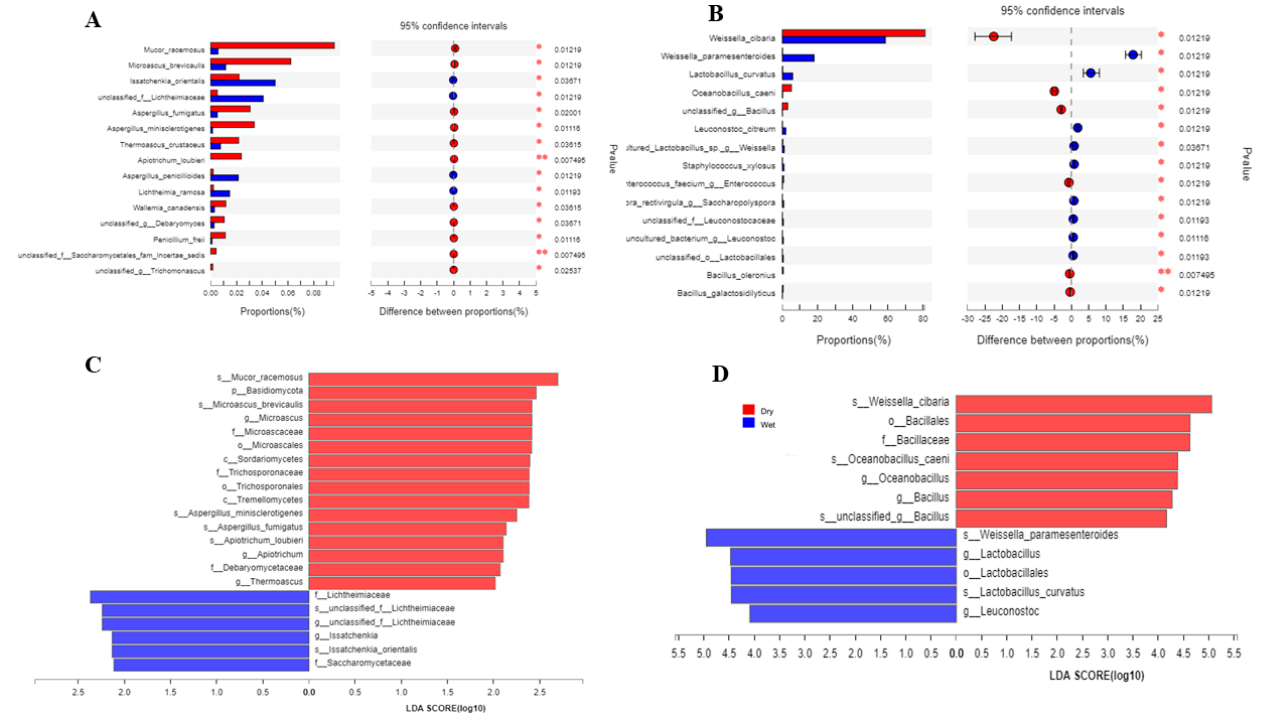
Figure 3. Colors in the figure show different groups. Names of specific taxa are displayed on the left; highly abundant tax are on the top, and the corresponding p value on the right represents a difference in the presence of that particular taxon in the groups. In contrast, the middle dots repre- sent the confidence interval. On the right, ( B ), are bacterial species, and on the left, ( A ), are taxon differences of fungal species. ( C ) Comparison and analysis of the relative differential abundance of fungi based on LDA score. ( D ) Comparison and analysis of the relative differential abundance of bacteria based on LDA score. LDA score table showing unique abundant taxa in each group of fungi and bacteria which gained LDA score ≥ 2.